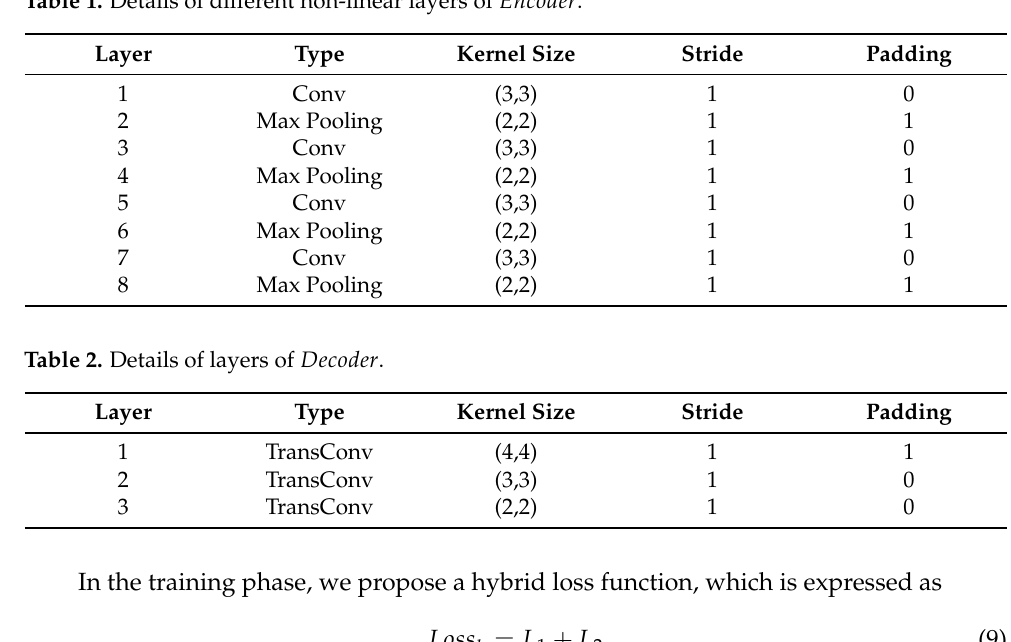
Figure 3. Structure of IRS-CRNet. Note that H α ∈ { H B , H U } . Table 1. Details of different non-linear layers of Encoder .